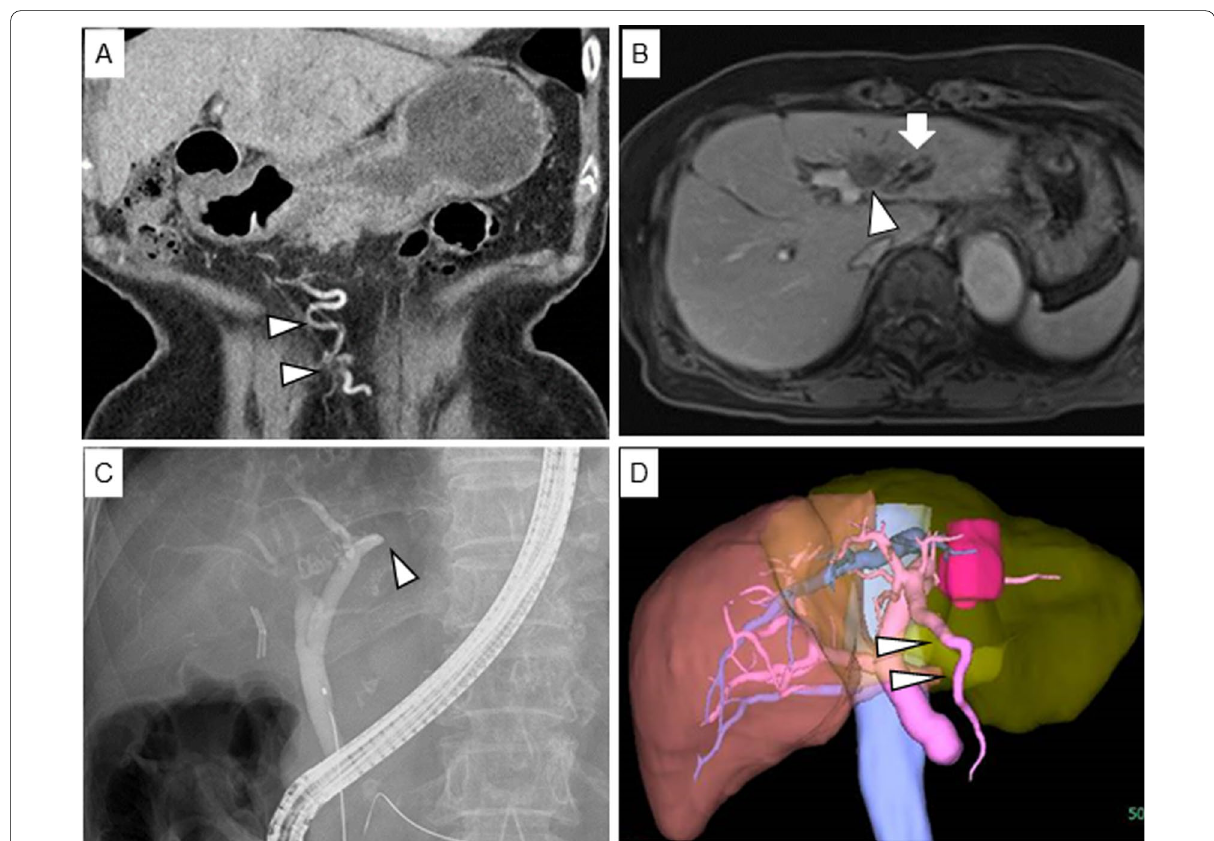
Fig. 1 Computed tomography revealed development of paraumbilical vein ( A , arrowhead). Magnetic resonance imaging revealed low-density tumor in contact with umbilical portion ( B , arrowhead) and shows bile duct dilation ( B , arrow). Endoscopic retrograde cholangiography showed that the left intrahepatic bile duct was disrupted (arrowhead) and there was obstructive jaundice due to tumor compression ( C ). Three-dimensional volumetry shows the remaining liver volume is 53% ( D ) and revealed development of paraumbilical vein (D,